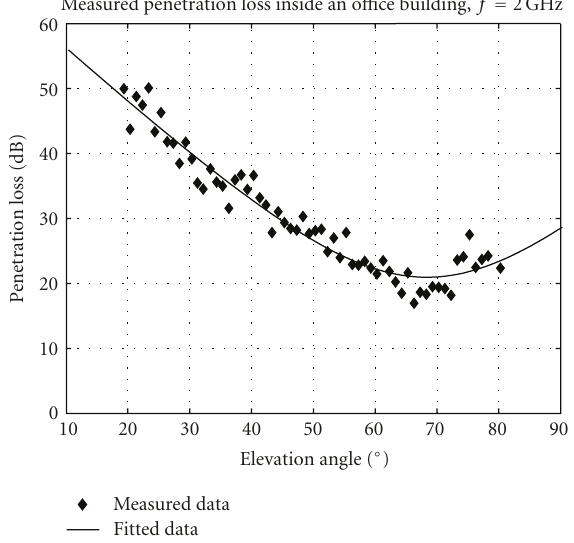
Figure 6: Mean penetration loss as a function of the elevation angle in o ffi ce building at 2.0 GHz.